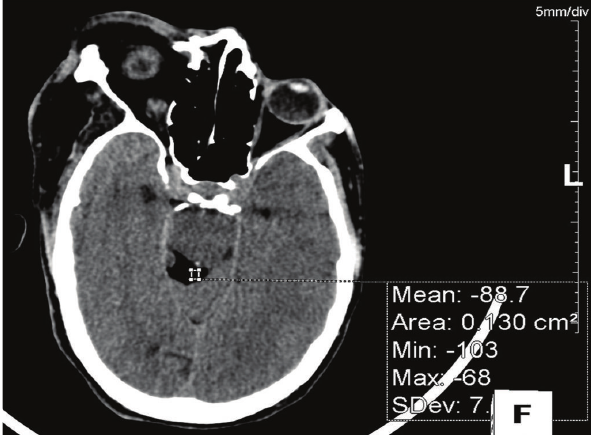
Figure 11: Axial CT scan showing a lipoma in the right quadrigem- inal cistern.